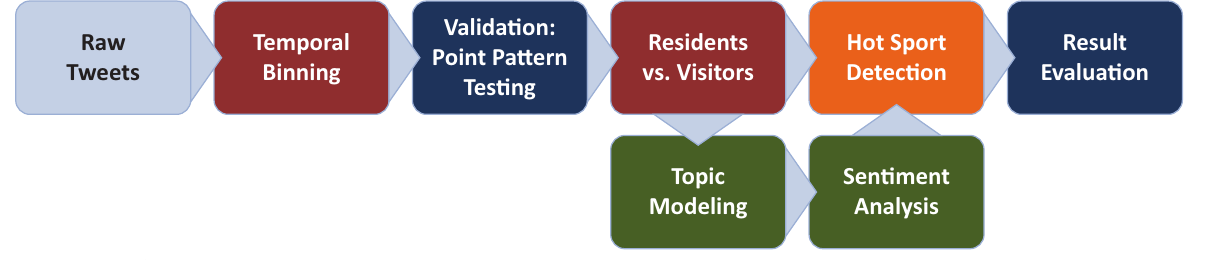
Figure 1. Workflow